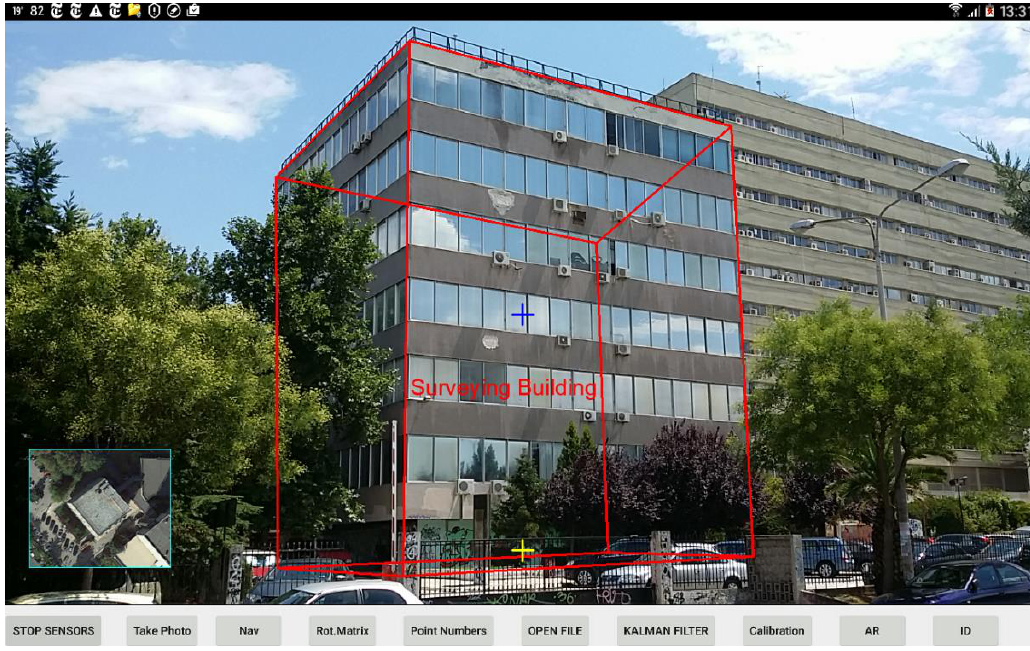
Figure 10. AR application on the mobile device display.